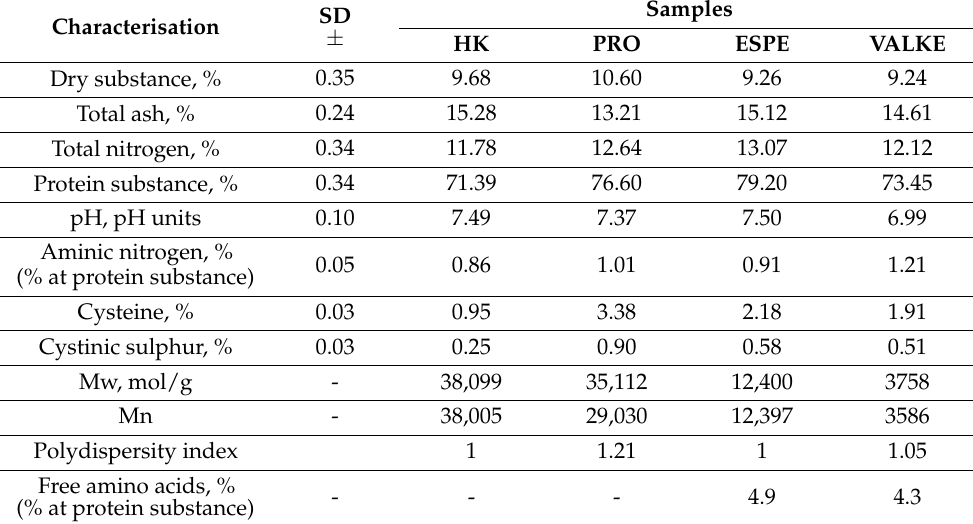
Table 1. Physico-chemical characteristics of keratin hydrolysates.